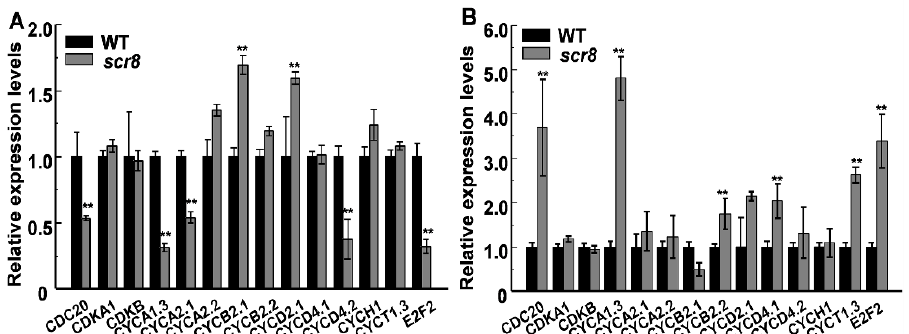
Figure 9. Expression analysis of genes related to cell cycle in WT and scr8. ( A ) Genes expression of WT and scr8 grown at 32 °C. ( B ) Genes expression of WT and scr8 grown at 20 °C. Error bars represent SD. ** Significant difference at p < 0.01 compared with the WT by Student’s t -test.